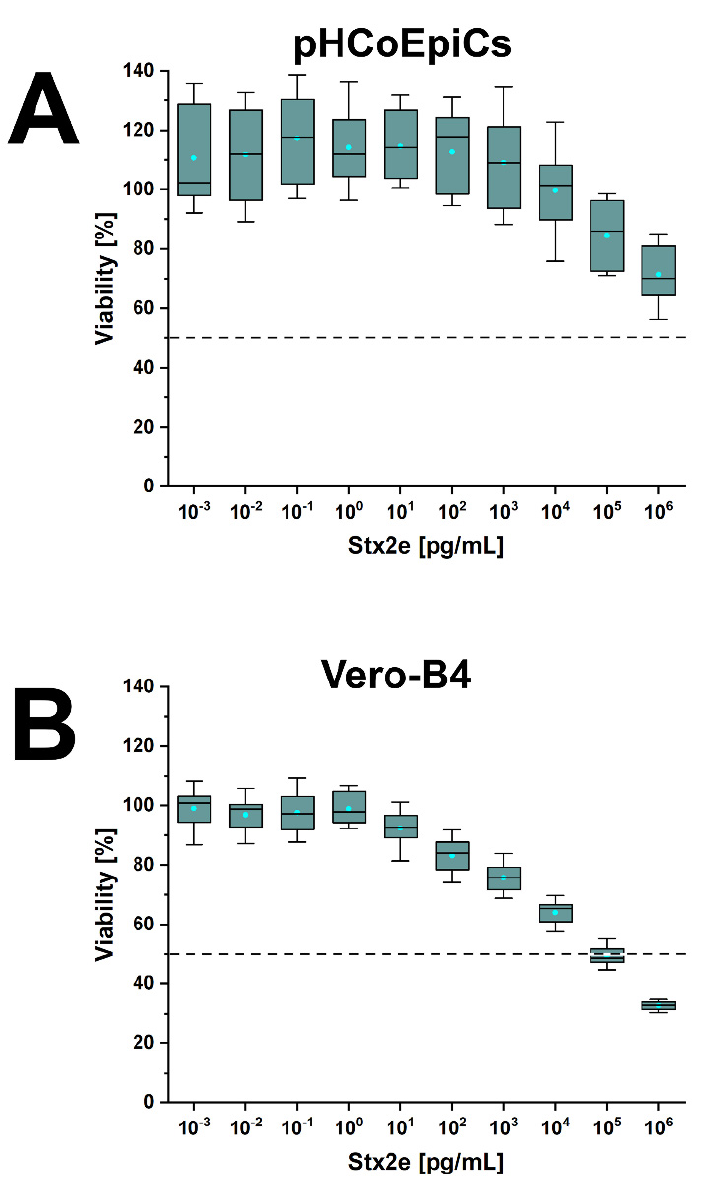
Figure 12. Cytotoxic effect of Stx2e towards pHCoEpiCs ( A ) and Vero-B4 reference cells ( B ). The cell-damaging activity was analyzed with the crystal violet assay, and absorption readouts of Stx2e-challenged cells are presented as box plots. Percentages of cell damage were determined in relation to parallel cell cultures without toxin serving as 100% viability control.